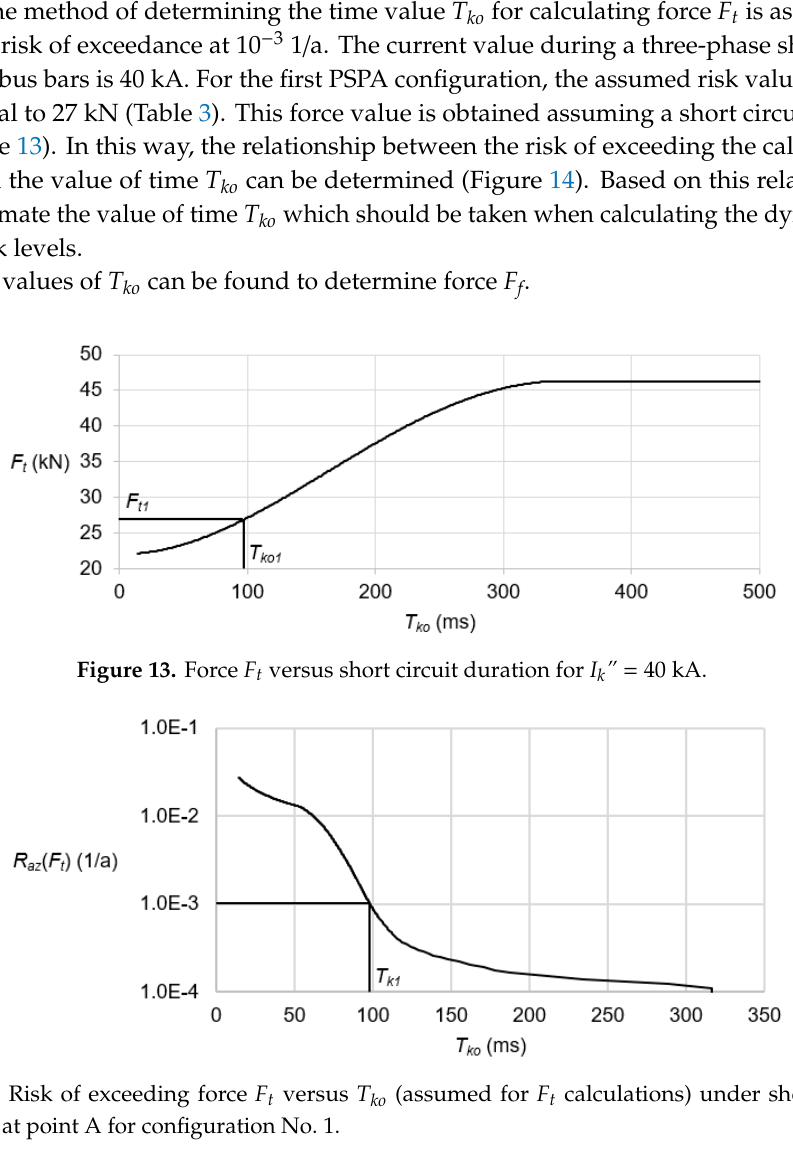
Table 4. Values of force F t and time T ko for defined risk levels and different PSPA configurations under short circuit conditions at lookout point A.